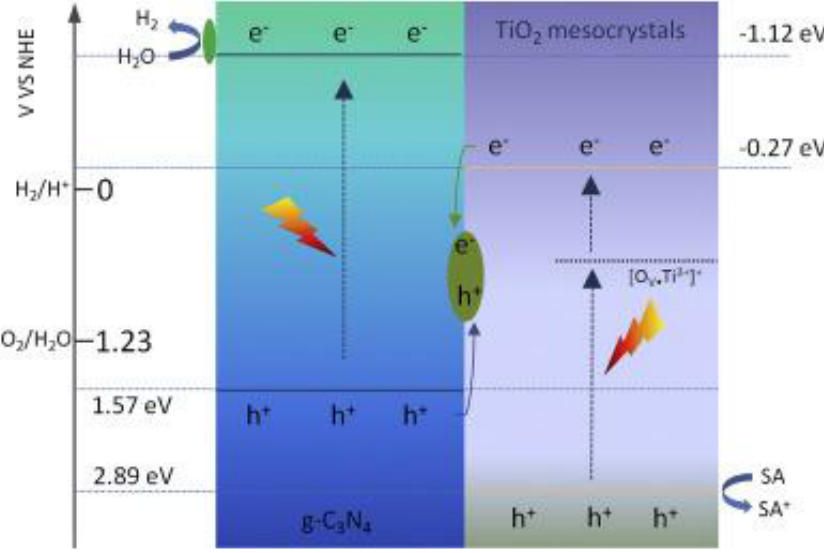
Figure 13. Possible visible light photocatalytic mechanism of Ti 3+ -doped meso–TiO 2 /g–C 3 N 4 Figure13. PossiblevisiblelightphotocatalyticmechanismofTi 3 + -dopedmeso–TiO 2 / g–C 3 N 4 composites composites for hydrogen production. Reproduced from [90] . Copyright (2017), Elsevier. for hydrogen production. Reproduced from [90]. Copyright (2017),